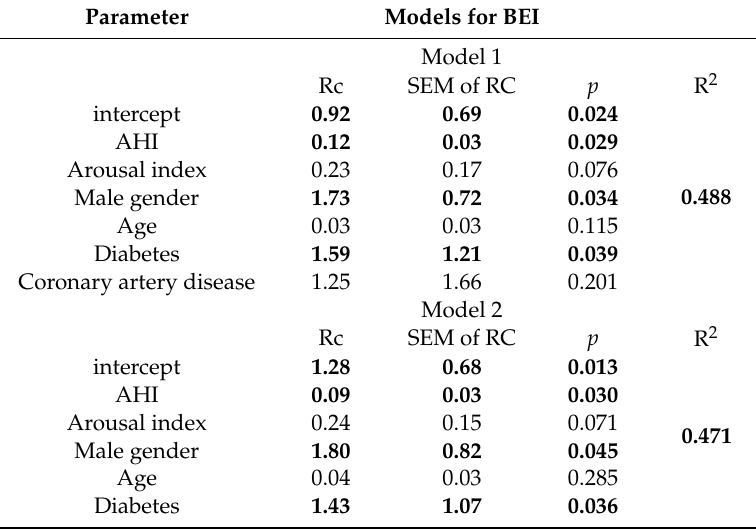
Table 4. The results of estimation for the models obtained with multivariate regression analysis in group with AHI < 30. Parameter Models for BEI